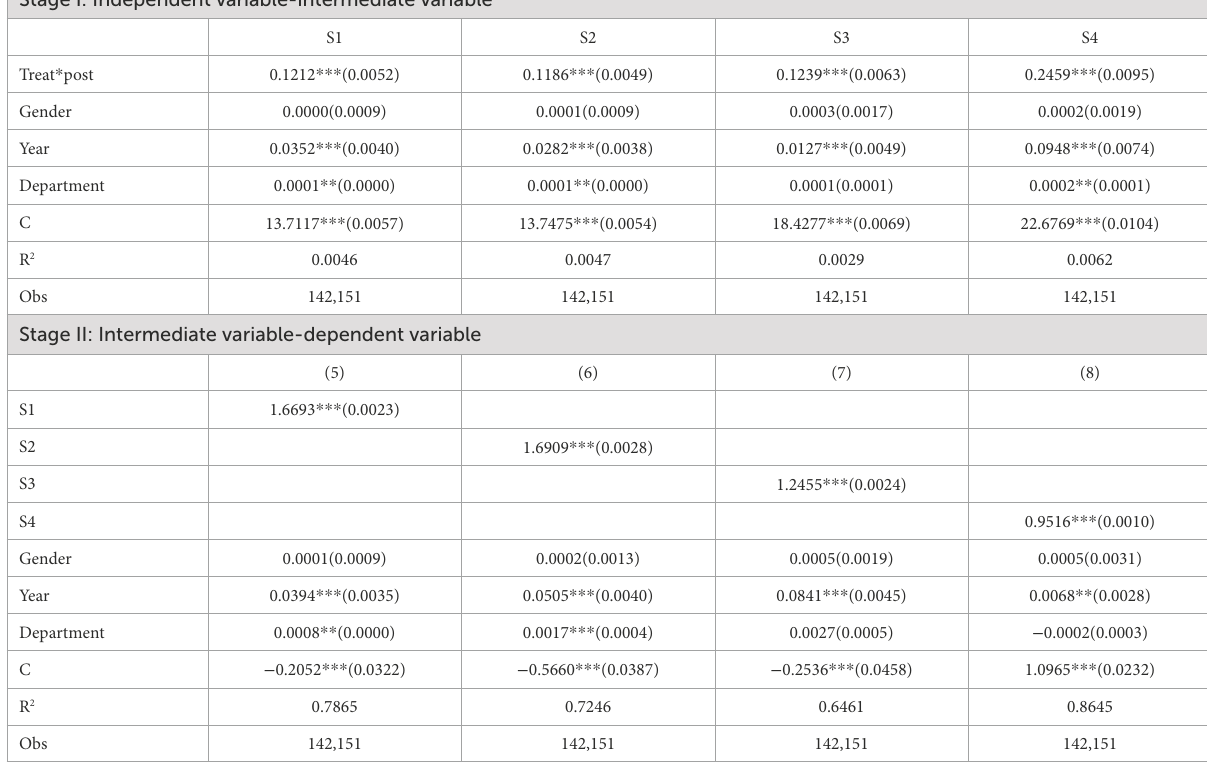
TABLE 7 Mediation effect test.